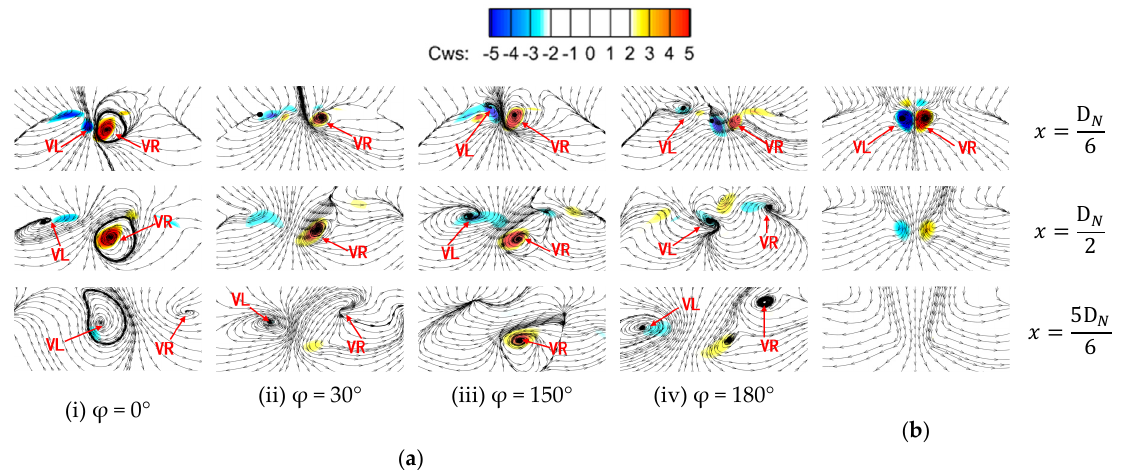
Figure 8. Streamwise vorticity for total pressure = 140kPa: ( a ) instantaneous streamwise vorticity of fluidic oscillator at various moments; ( b ) time-averaged streamwise vorticity of air tab.